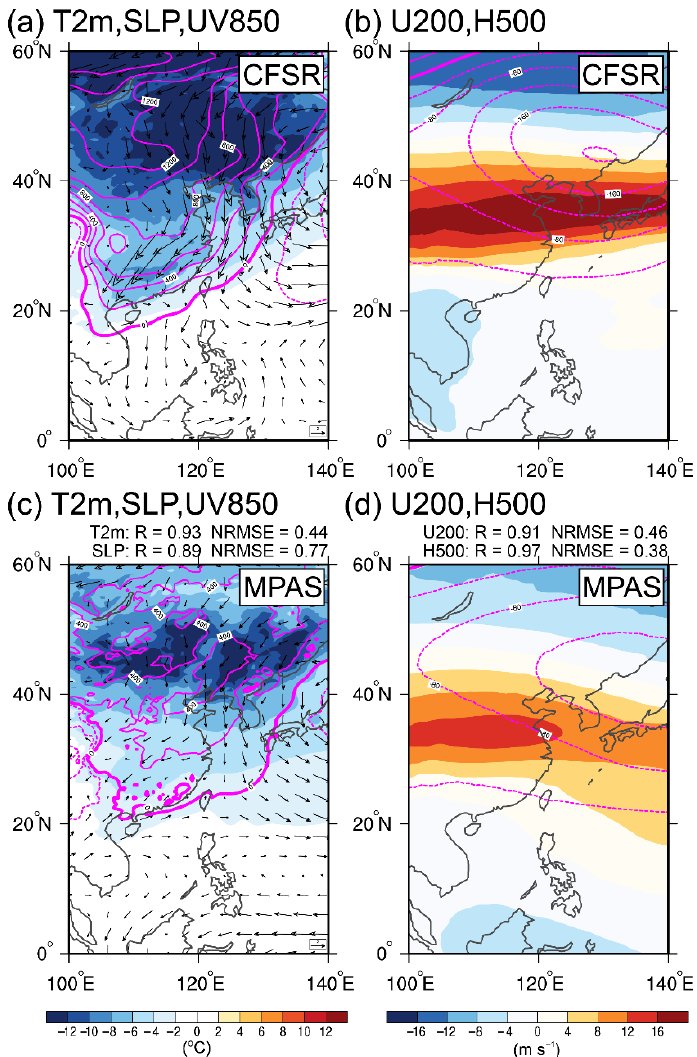
Figure 9. The difference between the composite anomalies of which PC1 greater than 1.0 and less than − 1.0 standard deviation. ( a , c ) T2m, SLP, and 850-hPa winds. ( b , d ) U200 and H500. The upper row for the CFSR and the lower row for the MPAS ensemble